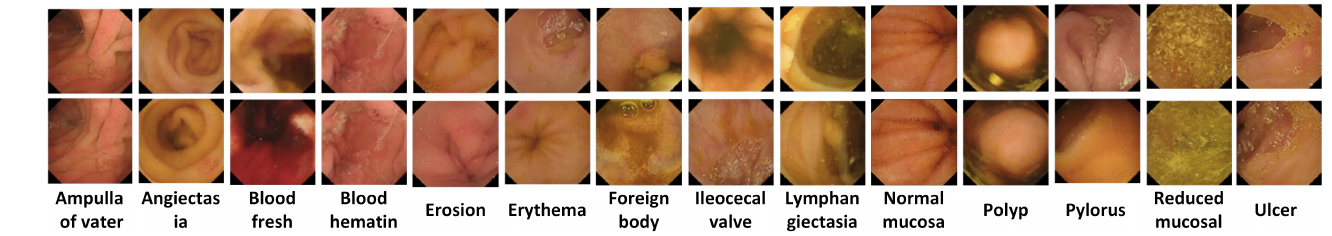
Figure 3. BL-SMOTE synthesizes image samples to handle the class imbalance problem.